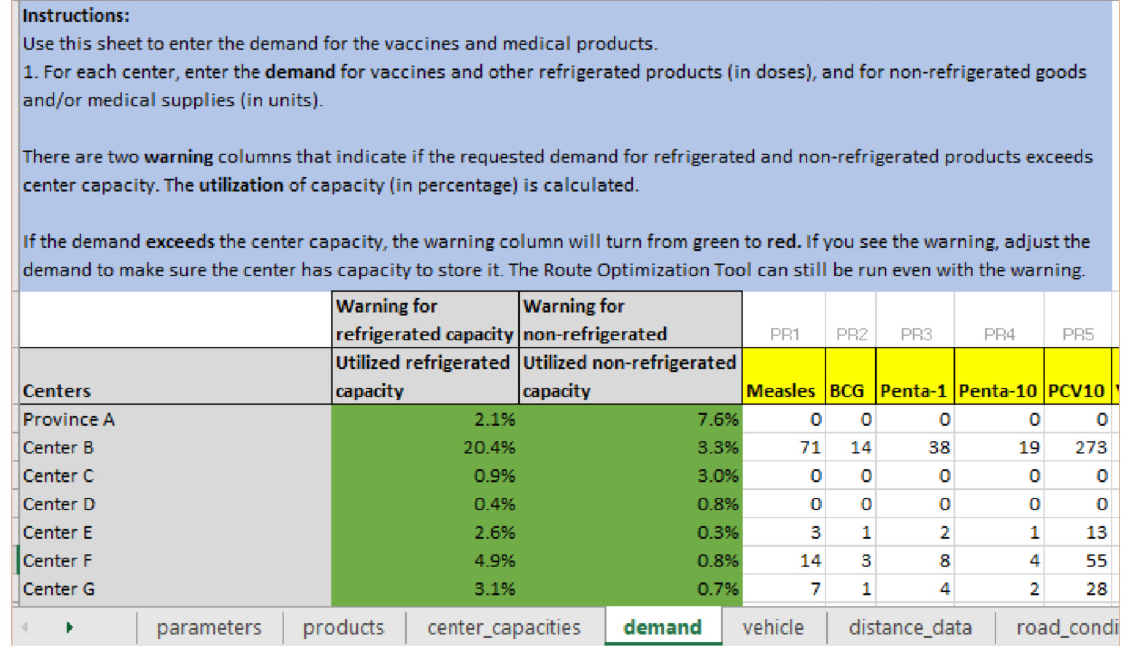
Figure 5. Change the demand for health facilities; set demand to zero for facilities that are not able to store health products at this time and adjust demand for other